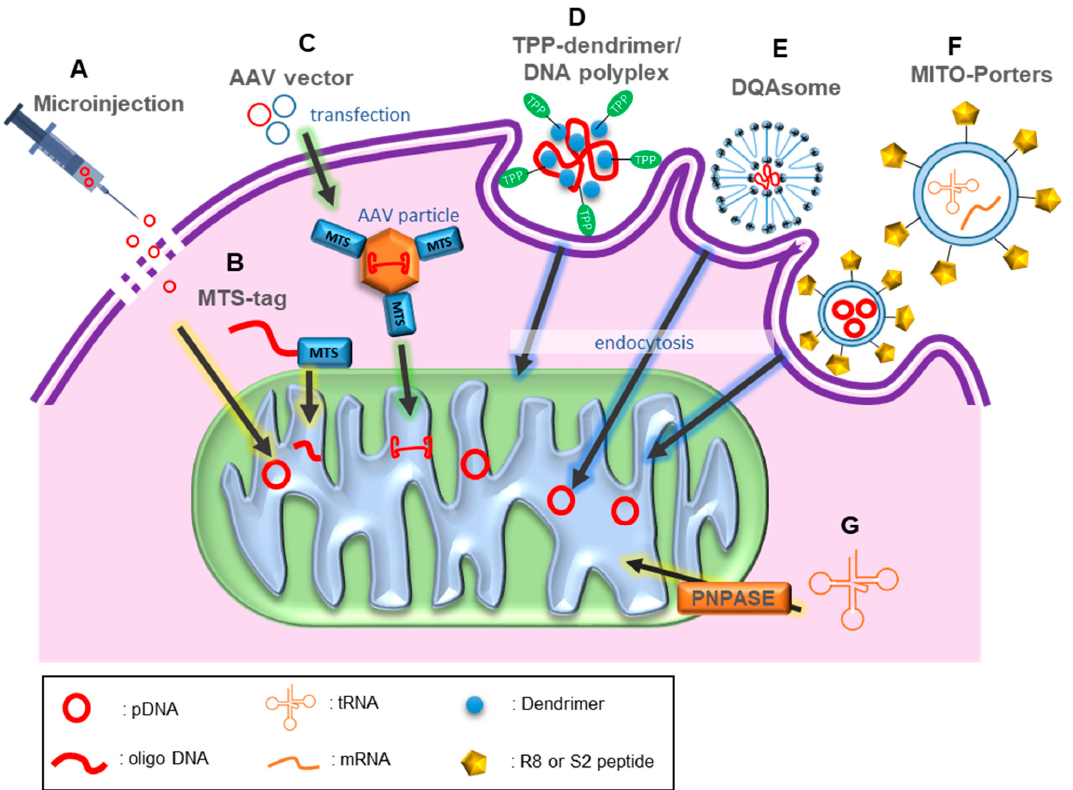
Figure 2. Methods for delivery of genetic components into mitochondria. ( A ) Microinjection is one of the physical methods. (B) MTS-mediated translocation can deliver DNAs into the mitochondrial matrix. ( C ) MTS-modified AAV particles can import target genes into mitochondria. ( D ) TPP-dendrimer/DNA polyplex is a dendrimer-based carrier that cannot